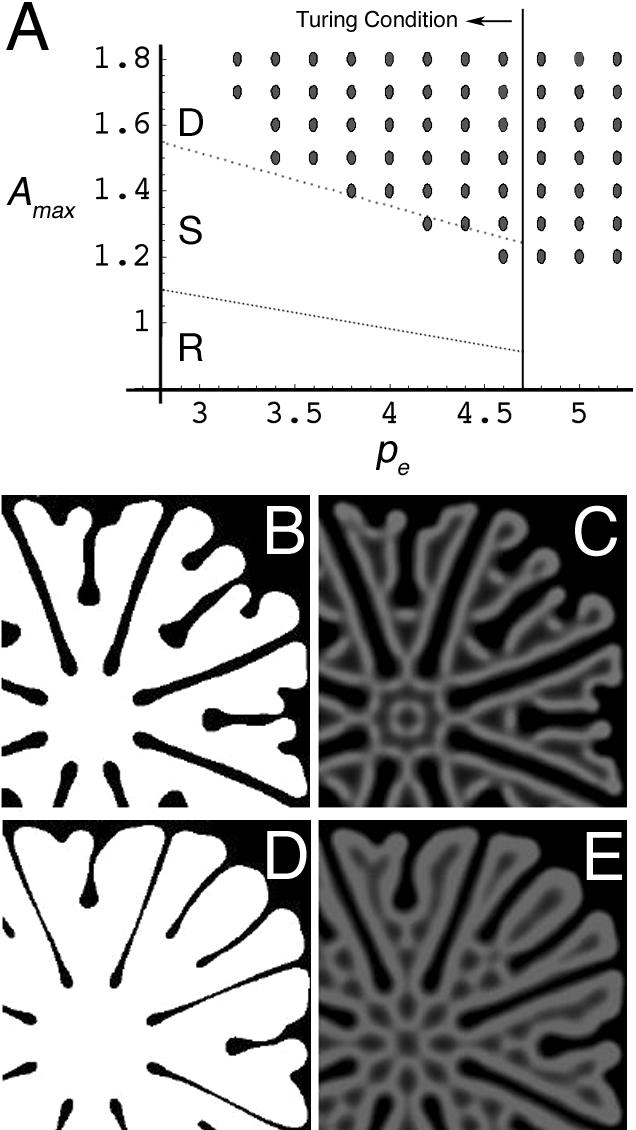
Comparative Analysis of Conditions for Dendritic Pattern Formation and Those for Dot, Stripe, and Reverse-Dot Pattern Generation(A) Condition of parameters for neuronal branching and Turing condition on a (pe − A
max)-plane. Simulations of the no-compartment model showed that dot, stripe, and reverse-dot domains are mapped to different parameter regions (D, S, and R, respectively); and dotted lines roughly represent boundaries between the domains. Closed circles: dendritic patterns obtained by our cell-compartment model. The fixed parameters were pa = 0.7, pb = 0.8, d = 30.0, ph = 1.0, R = 0.004, and γ = 625. We used Tr = 0.95 (when A
max = 1.0), Tr = 0.85 (when A
max = 0.9), and Tr = 1.0 (otherwise). Total calculation time was 4 × 105 steps.(B–E) Typical examples in the stripe domain (B,C): pe = 4.0, A
max = 1.1, and Tr = 1.0, and in the reverse-dot domain (D,E): pe = 3.6 and Tr = 0.95. Dendrites (B,D) and the distribution of the activator (C,E) are shown.